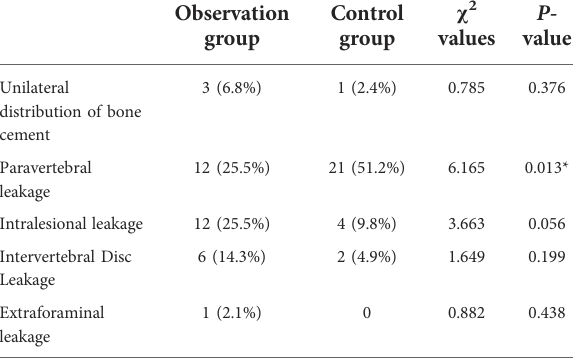
TABLE 3 Distribution and leakage of bone cement (%).